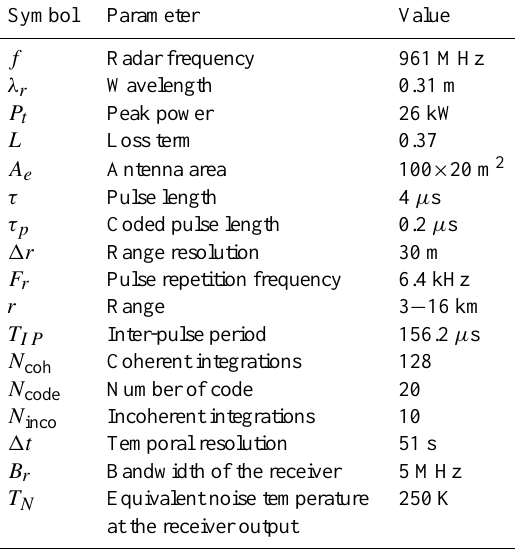
Table 1. PROUST radar